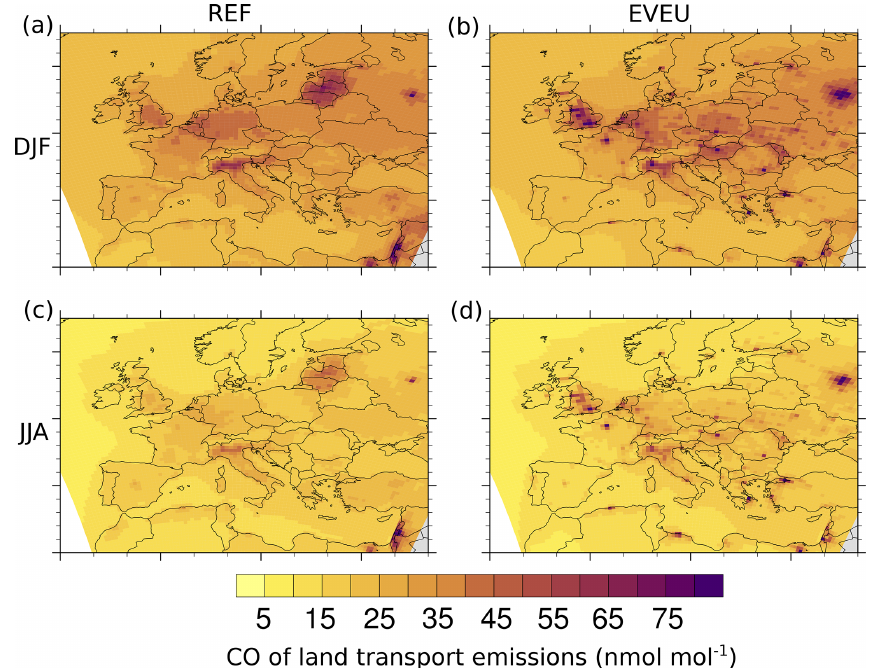
Figure 5. Absolute contribution of land transport emissions to ground-level CO (in nmolmol − 1 ) as simulated by CM50. Panels (a) and (b) are contributions for the period DJF of the REF and EVEU simulations, respectively. Panels (c) and (d) are contributions for the period JJA of the REF and EVEU simulations,